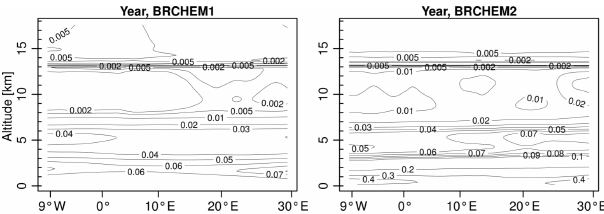
Figure 9. Vertical longitudinal profiles of Bromine annual mean concentrations (ppt) using p-TOMCAT concentrations (BRCHEM1 experiment, left panel) and GEOSCHEM concentra- tions (BRCHEM2 experiment, right